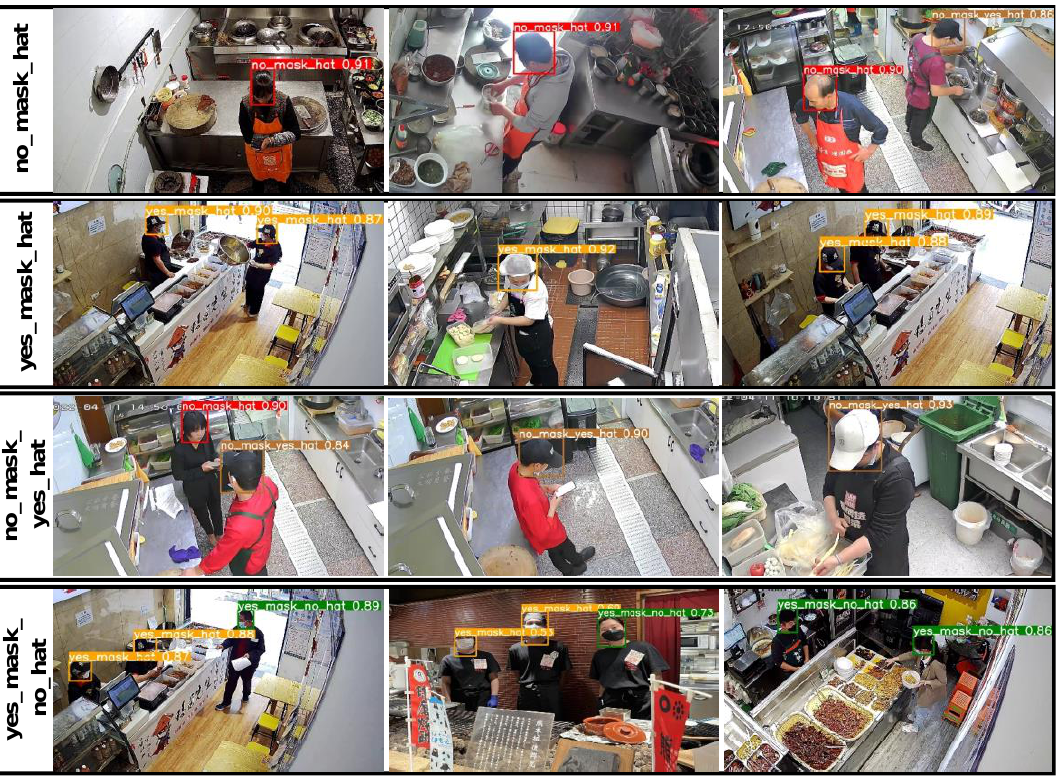
Figure 9. The detection performance of the YOLOv5s embedded model. It should be noted that the colors orange, green, red, and copper represent the labels yes_mask_hat, yes_mask_no_hat, no_mask_hat, and no_mask_yes_hat, respectively.